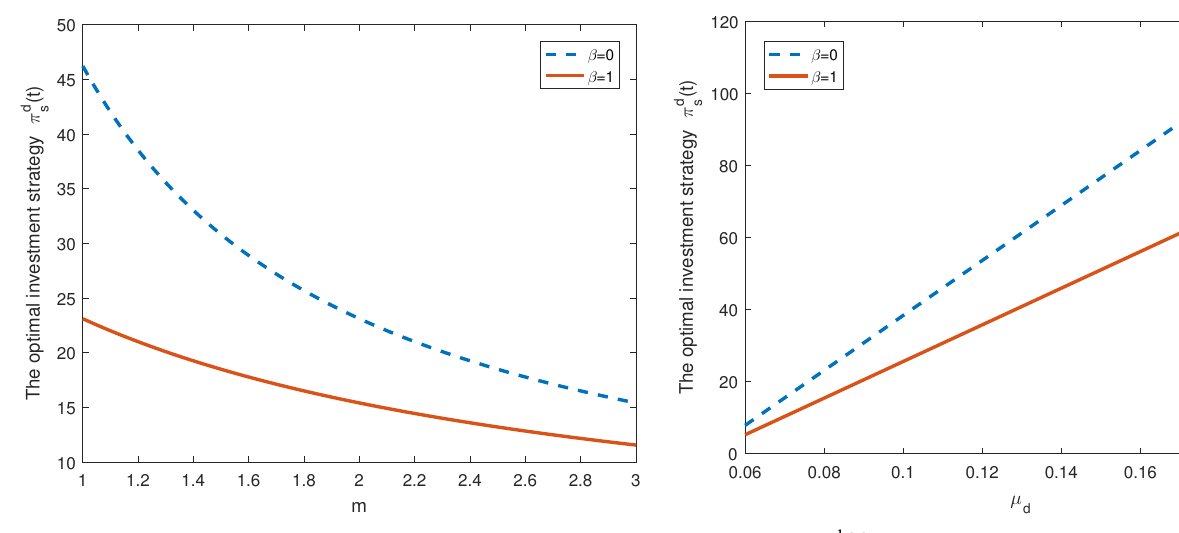
Figure 2. The impact of parameters m and µ d on π d s ( t ) .